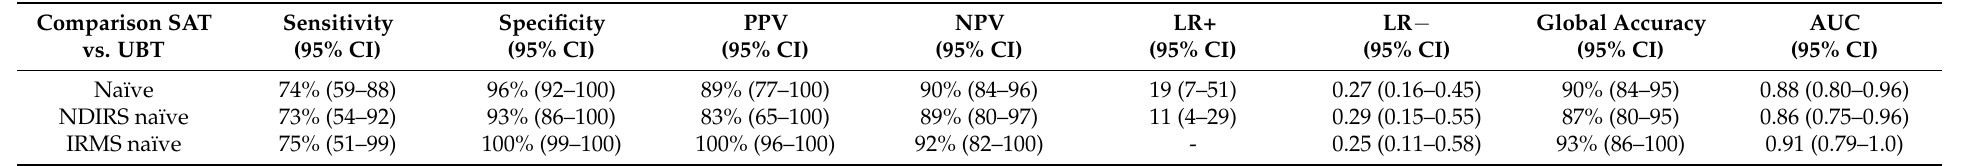
Table 2. Accuracy of the LIAISON ® Meridian H. pylori SA test in treatment-naïve patients.